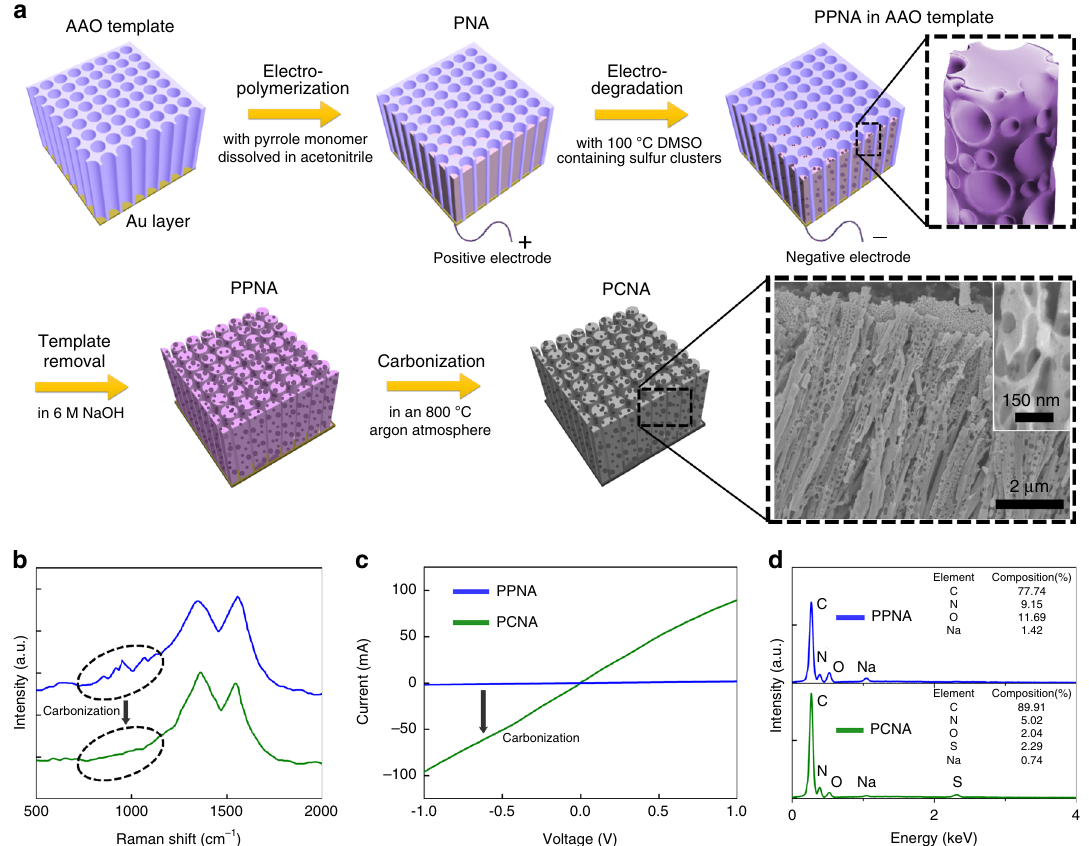
Fig. 1 Synthesis and characterization of the PCNA. a Steps for synthesizing the PCNA. The bottom right inset shows an SEM image of the PCNA and an enlarged SEM image of a single porous carbon nanowire. b Raman spectra of the PPNA and PCNA. After the carbonization process, all the characteristic Raman peaks of the PNA at 870, 930, 1050, and 1246 cm − 1 disappeared as evident in the PCNA spectrum. c I – V curve measurements of the PPNA and PCNA. In the measurements, the length and contact area of the porous PPy nanowires and porous carbon nanowires are about 15 μ m and 0.5 mm 2 , respectively. The conductivity of the substrate was signi fi cantly increased after the carbonization process, indicating the semiconducting property of the PCNA. d EDS spectra of the PPNA and PCNA. The composition ratio of carbon was signi fi cantly increased after the carbonization